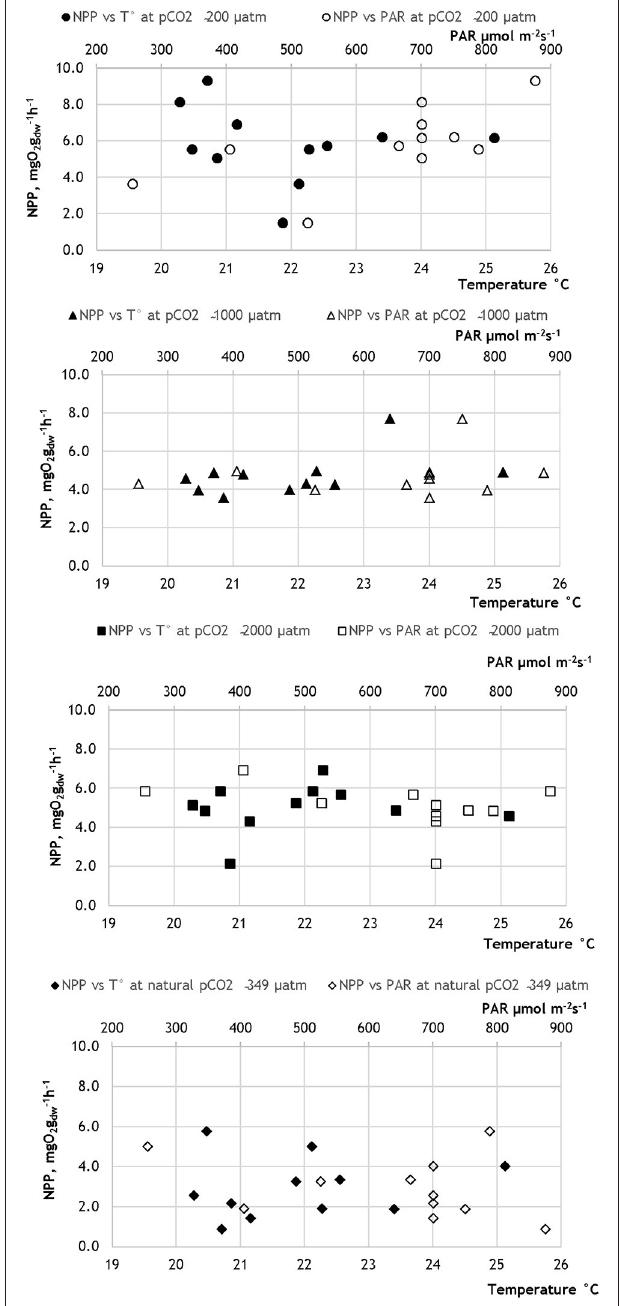
FIGURE 3 | Net photosynthesis rates (NPP) plotted against water temperature (T ◦ ) and photosynthetically active radiation (PAR) at different pCO 2 levels in